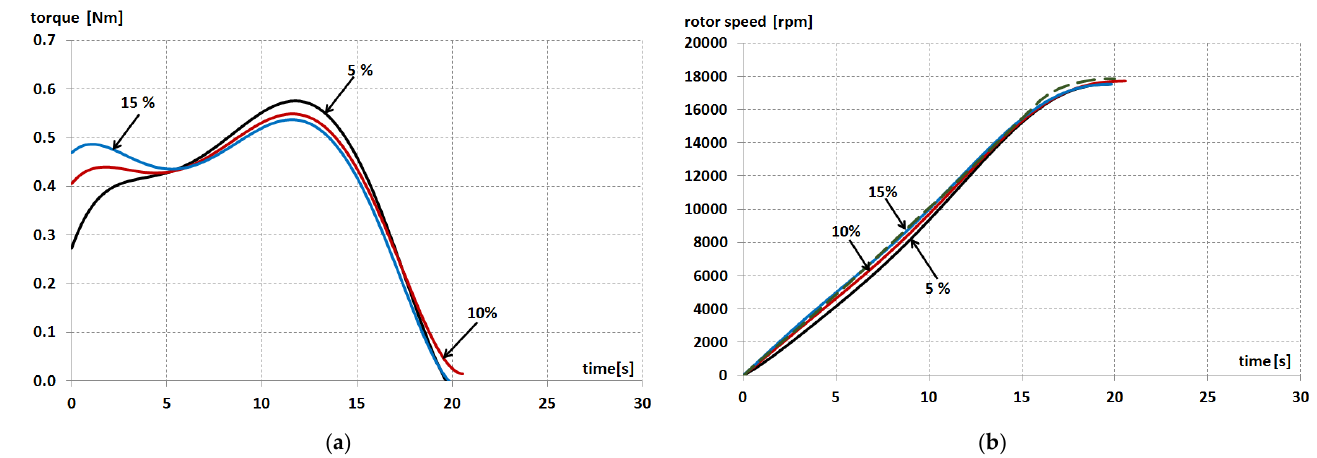
Figure 14. The measured waveforms of dynamic electromagnetic torque ( a ) and measured (solid line) and calculated (dashed line) rotational speed ( b ) at the motor frequency start-up with a frequency rise time of 5 s and a different value of the initial voltage, for the motor with additional inertia mass ( J = 0.00454 kg m 2 ). ( a ): caption, ( b ): caption.